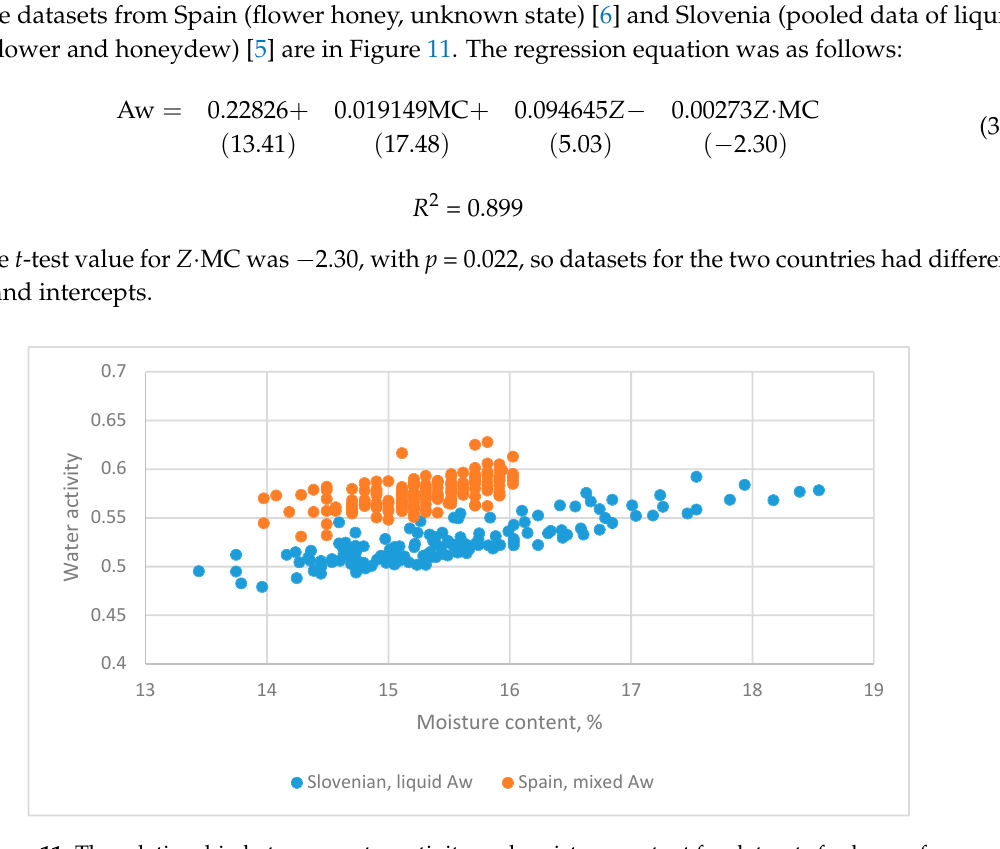
Figure 11. The relationship between water activity and moisture content for datasets for honey from Spain (flower honeys, unknown state) [6] and Slovenia (pooled data of liquid states, flower and honeydew) [5].